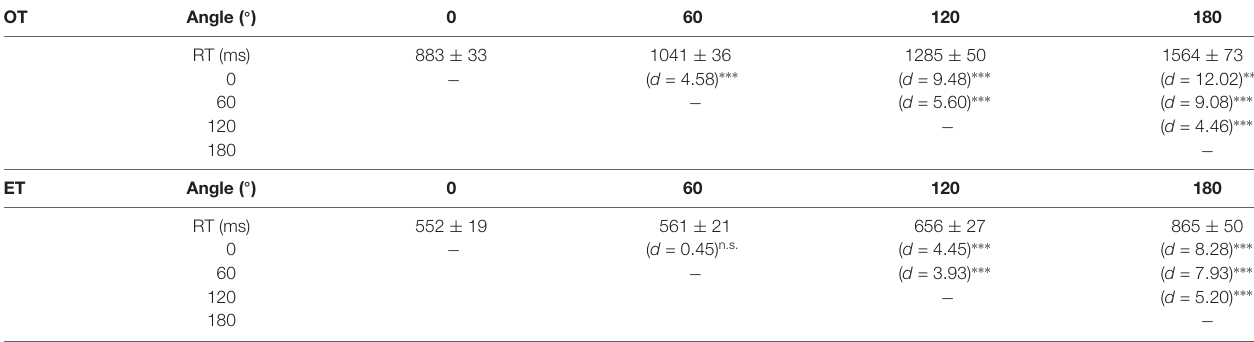
TABLE 1 | Reaction time per group in object-based transformations (OT) and egocentric transformations (ET) conditions ( M ± SE ).